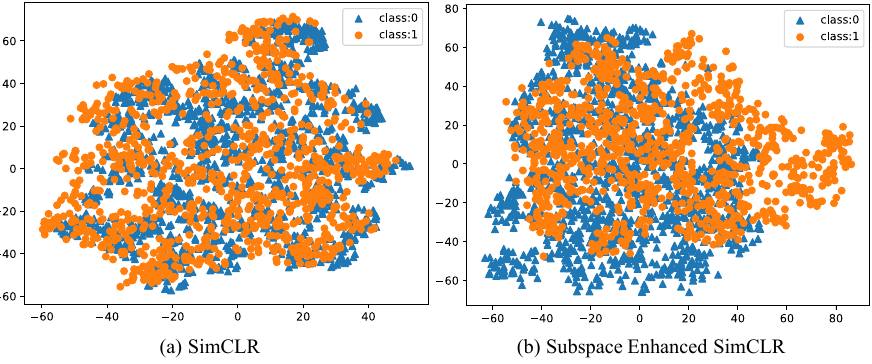
Figure 3. Visualization. 2D image features from SimCLR and the proposed Subspace Enhanced SimCLR are scattered in two subplots,